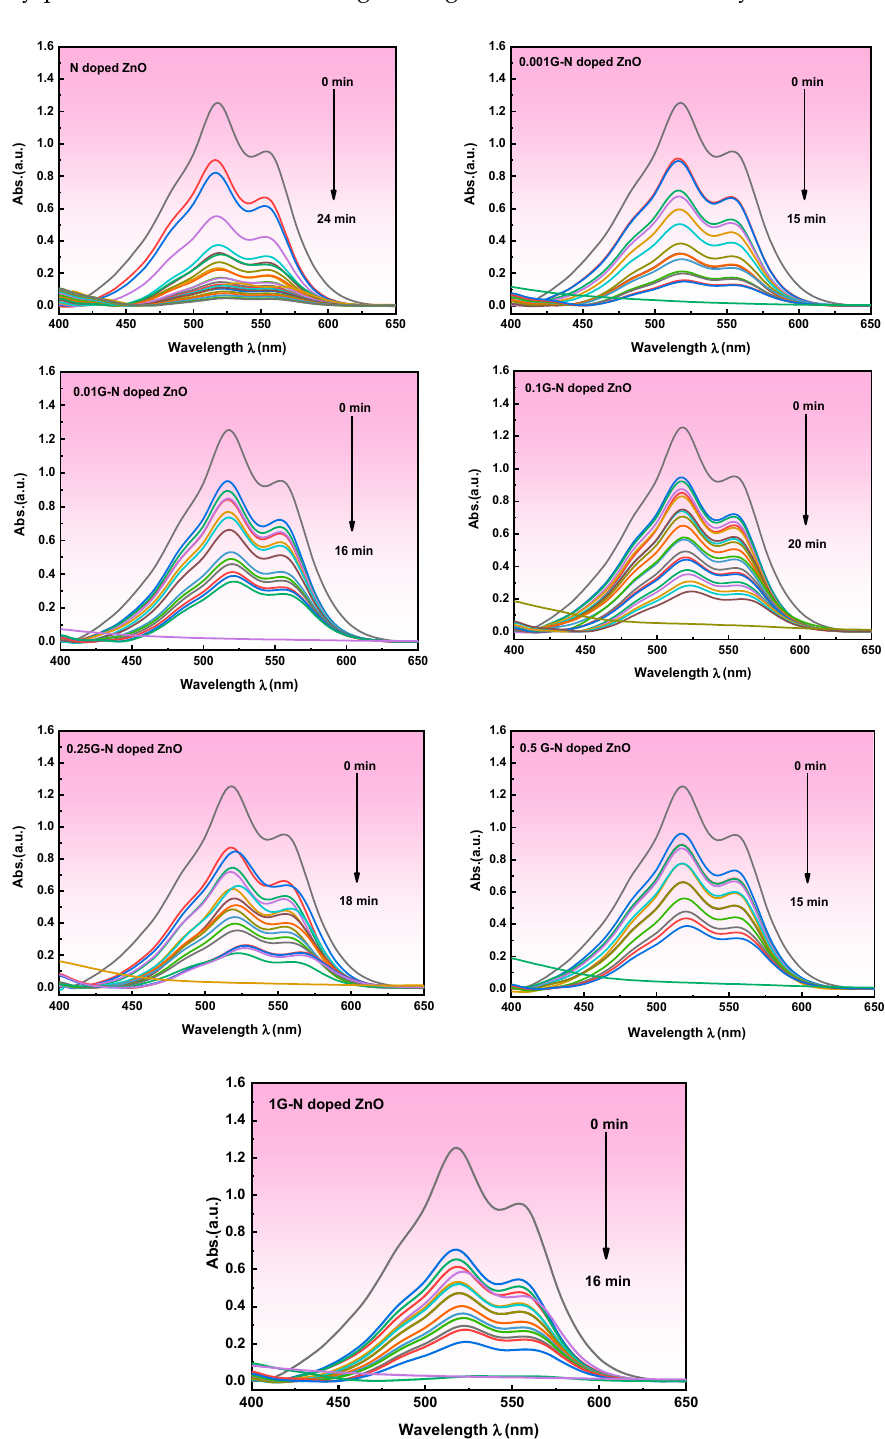
Figure 8. UV–Vis absorbance spectra of indirect electrochemical degradation of carmine dye in the presence of N-doped ZnO and G/N-doped ZnO with different concentrations of graphene.